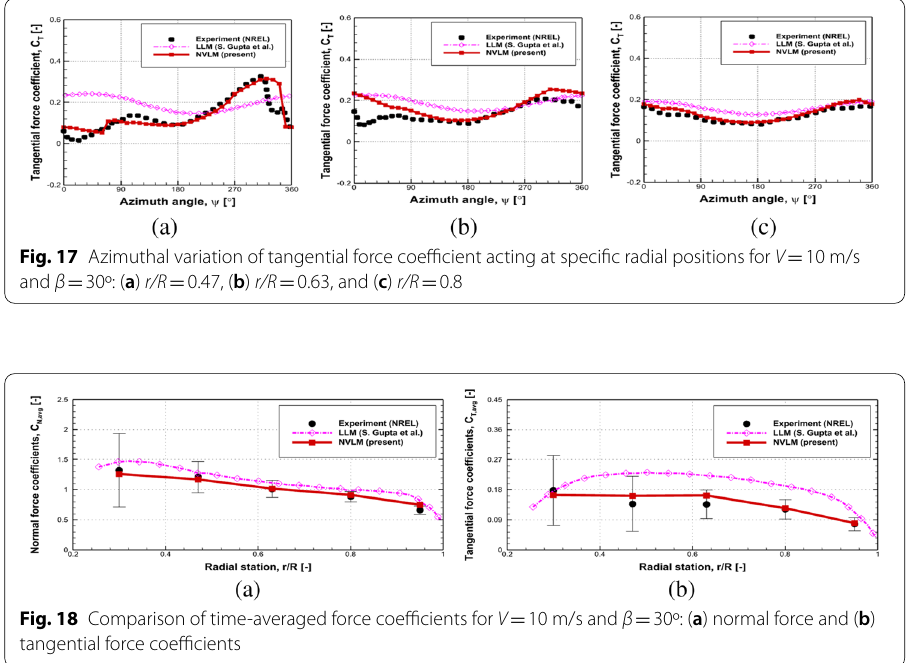
10 m/s and β 30º: ( a ) normal force and ( b ) = =